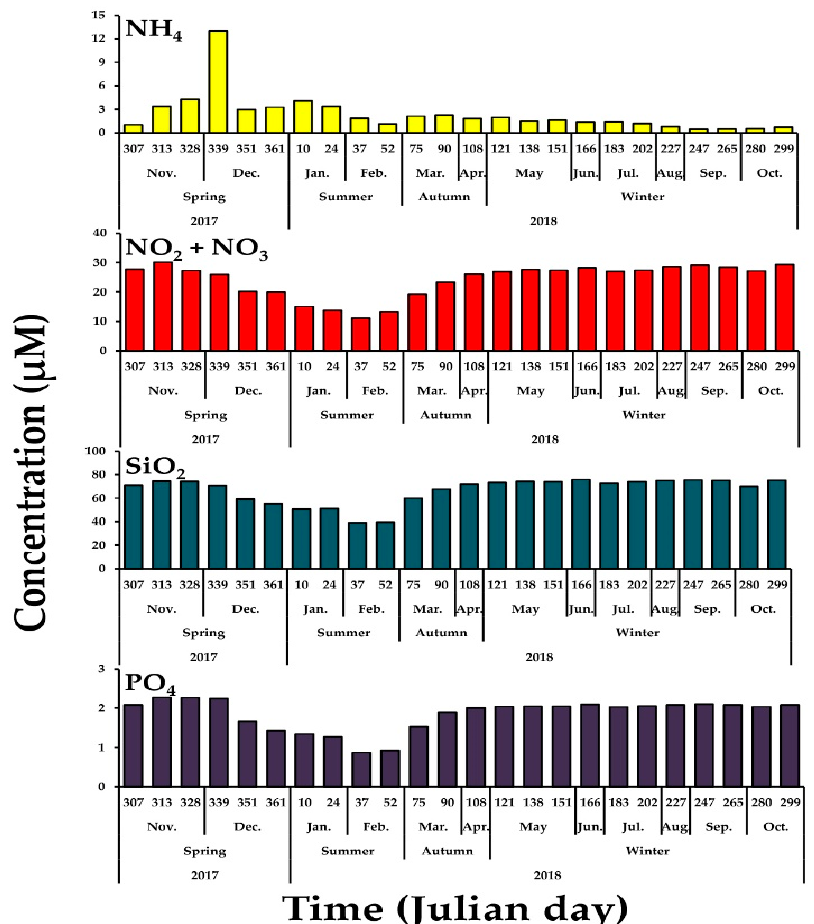
(Figure 4). The average C/N ratios of POM were 7.1 ( ± 1.0), 5.9 ( ± 0.4), 8.3 ( ± 0.7), and 10.6 ( ± 0.9) during spring, summer, autumn, and winter, respectively.